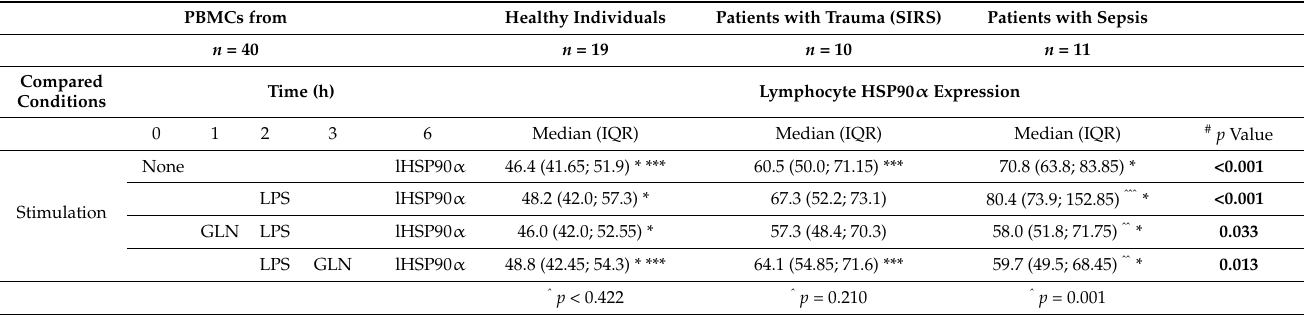
Table 4. Comparison analysis of lymphocyte HSP90 α expression among different stimulation con- ditions with or without glutamine pre- or post-treatment in patients with sepsis or trauma, and healthy